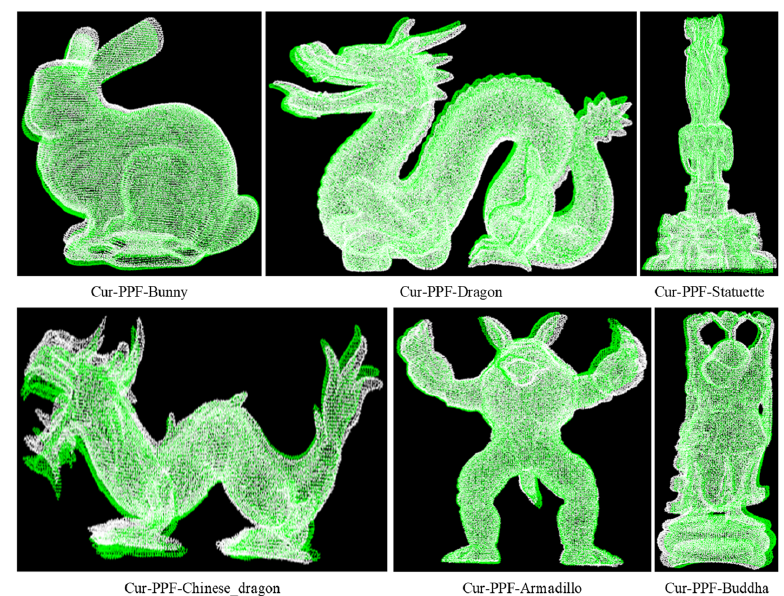
Figure 13. The weighted Cur-PPF algorithm is used to register the six kinds of point cloud models of the data set. The pose results are used to convert the point cloud of the models into scene space, and the color is used for rendering, where white represents the point cloud of the scene, and green represents the converted model point cloud. Table 3. The matching rate of Cur-PPF(Unweight) and Cur-PPF algorithms on public data set.